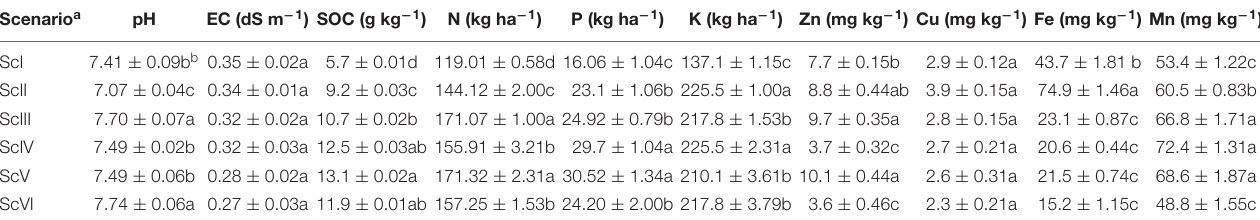
FIGURE 6 | Venn graphs based on the presence of different phyla in scenarios. TABLE 3 | Soil Chemical properties and available nutrients in soils after wheat